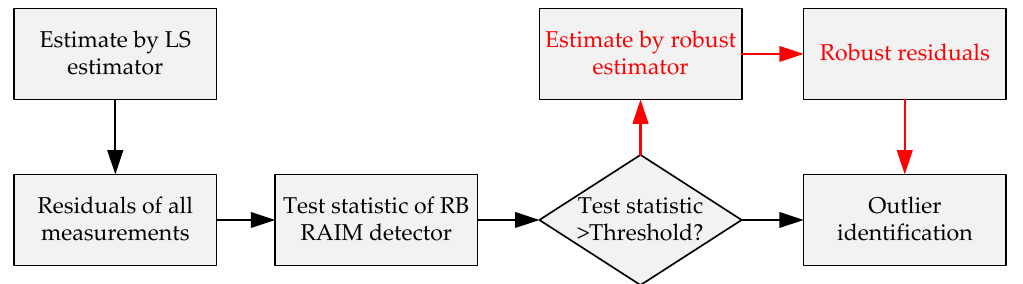
Figure 1. Flow chart of a residual-based (RB) receiver autonomous integrity monitoring (RAIM) detector based on a robust estimator.